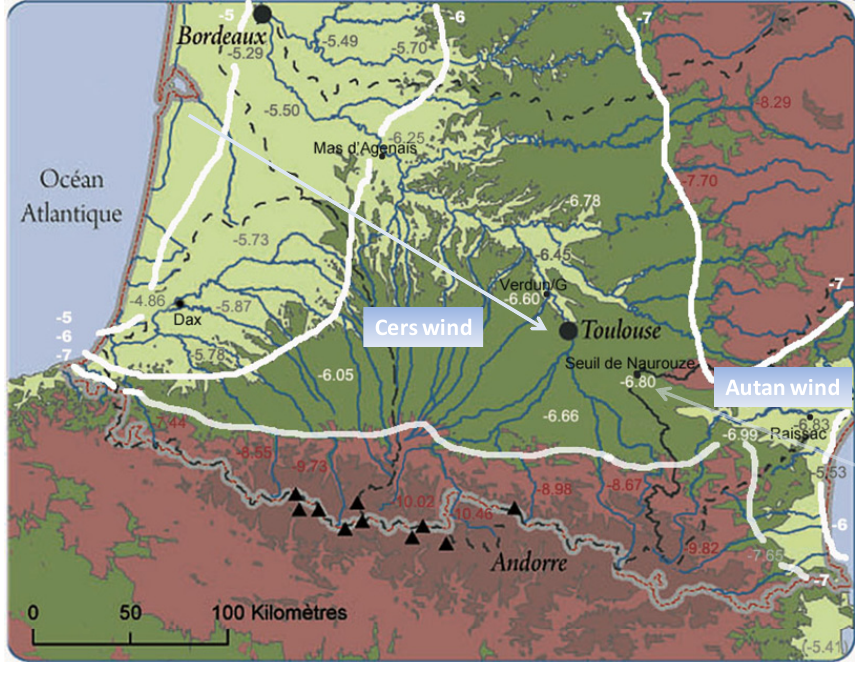
Figure 1. The Southwest of France with the localization of the sample sites with the typical δ 18 O value of the groundwater (in white) and the upstream basin (in red). The resulting isovalue contour for δ 18 O = − 5‰, − 6‰ and − 7‰ are given with a white line, and the two dominant wind directions are given by both